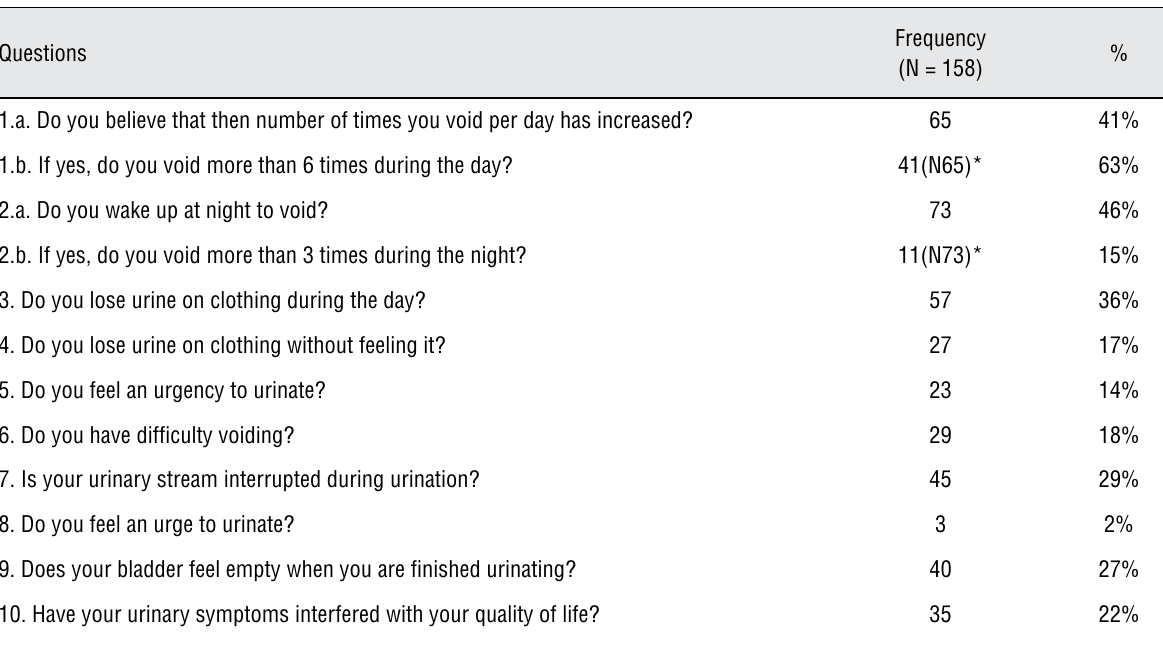
Table 2 - Frequency of each question in the questionnaire.